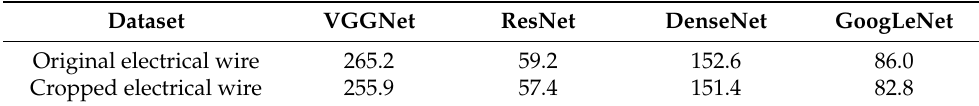
Table 4. The average training time for one epoch.